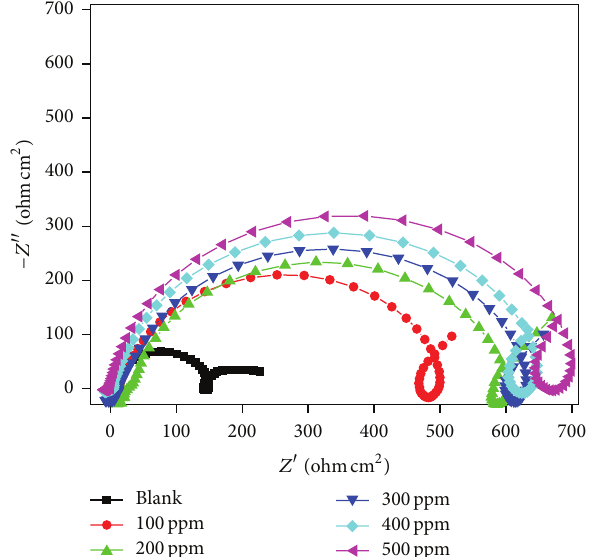
Figure 3: Nyquist plots and equivalent circuit for the corrosion of aluminum in 0.5 M phosphoric acid solution containing different concentrations of inhibitor (GIE) at 30 ∘ C.